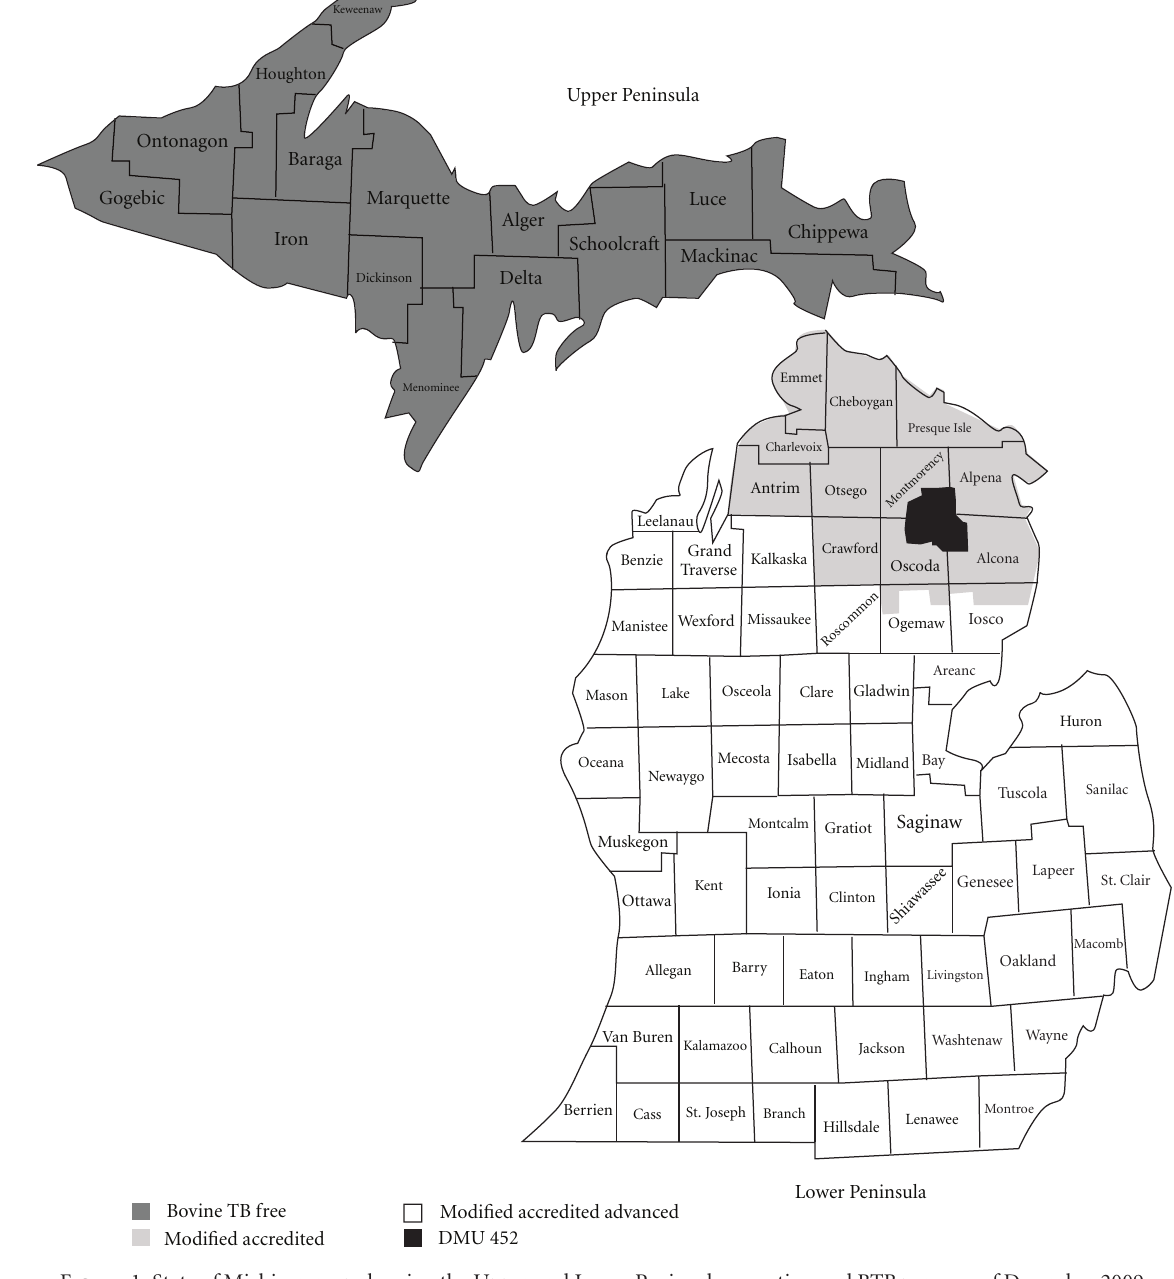
The overall number of cattle herds in each county and those found infected with BTB is presented in Table